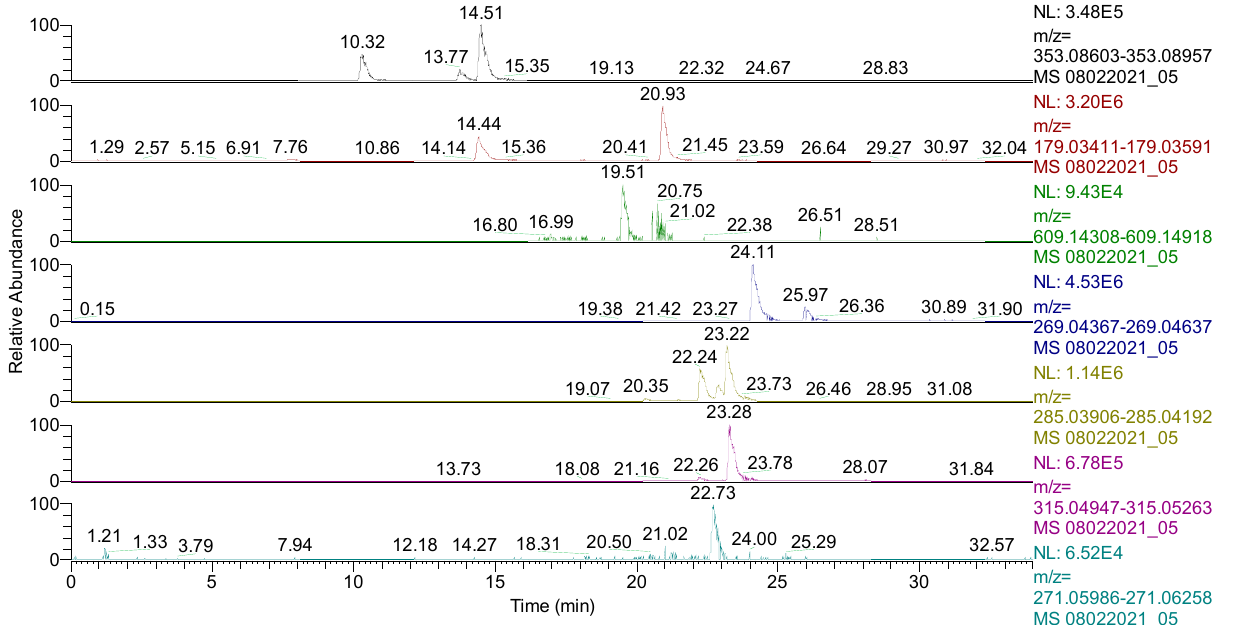
Figure 3. UHPLC–HRMS/MS chromatogram for RE in which were identified (top to bottom): chlorogenic acid ( m/z : 353.08783, Rt: 10.32/14.51), caffeic acid/isomers ( m/z : 179.03501, Rt: 14.44/20.93), rutin ( m/z : 609.14613, Rt: 19.51), apigenin ( m/z : 269.04502, Rt: 24.11), kaempferol ( m/z : 285.04049, Rt: 23.22), naringenin ( m/z : 271.06122, Rt: 22.73). Table 4. Chemical compounds identified in TE by UHPLC–HRMS/MS. TE–39 Identified